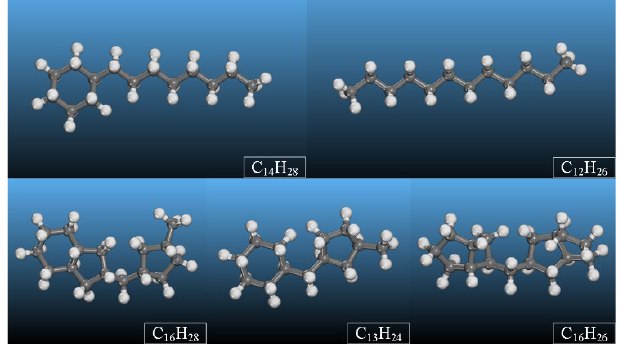
Figure 2. Atomic structures of the main constituent molecules in the Karamay 25 # insulating oil.